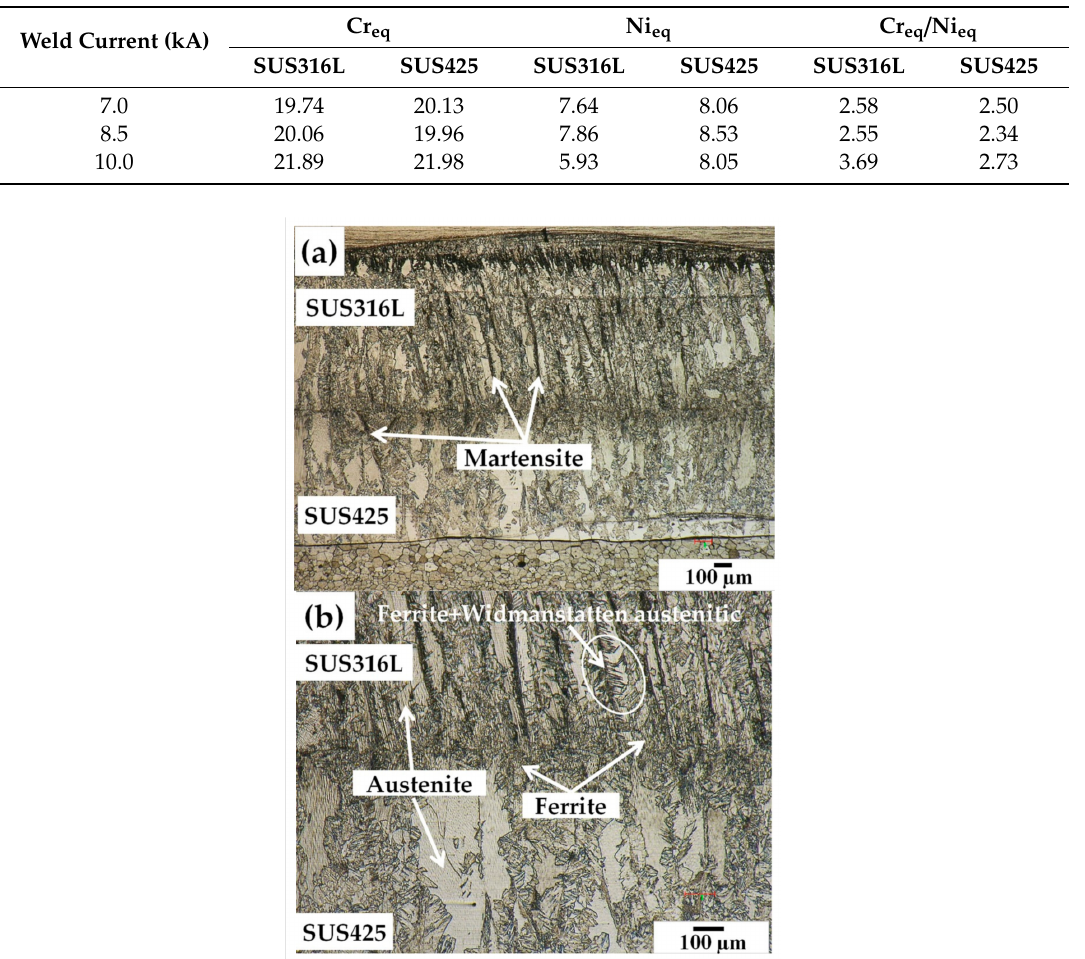
Figure 17. OM images of the fusion zone of SUS316L / SUS425 RSW: ( a ) 100x; ( b )